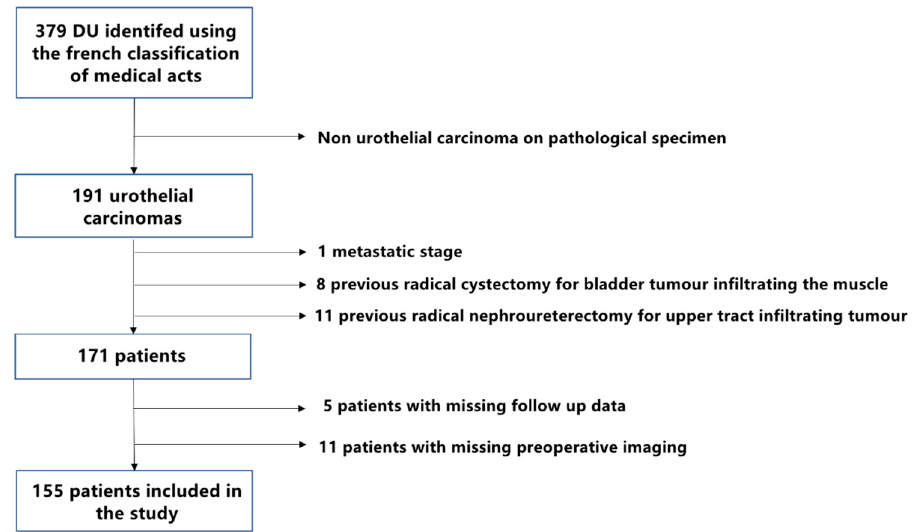
Figure 1. Flow chart for patients’ selection.